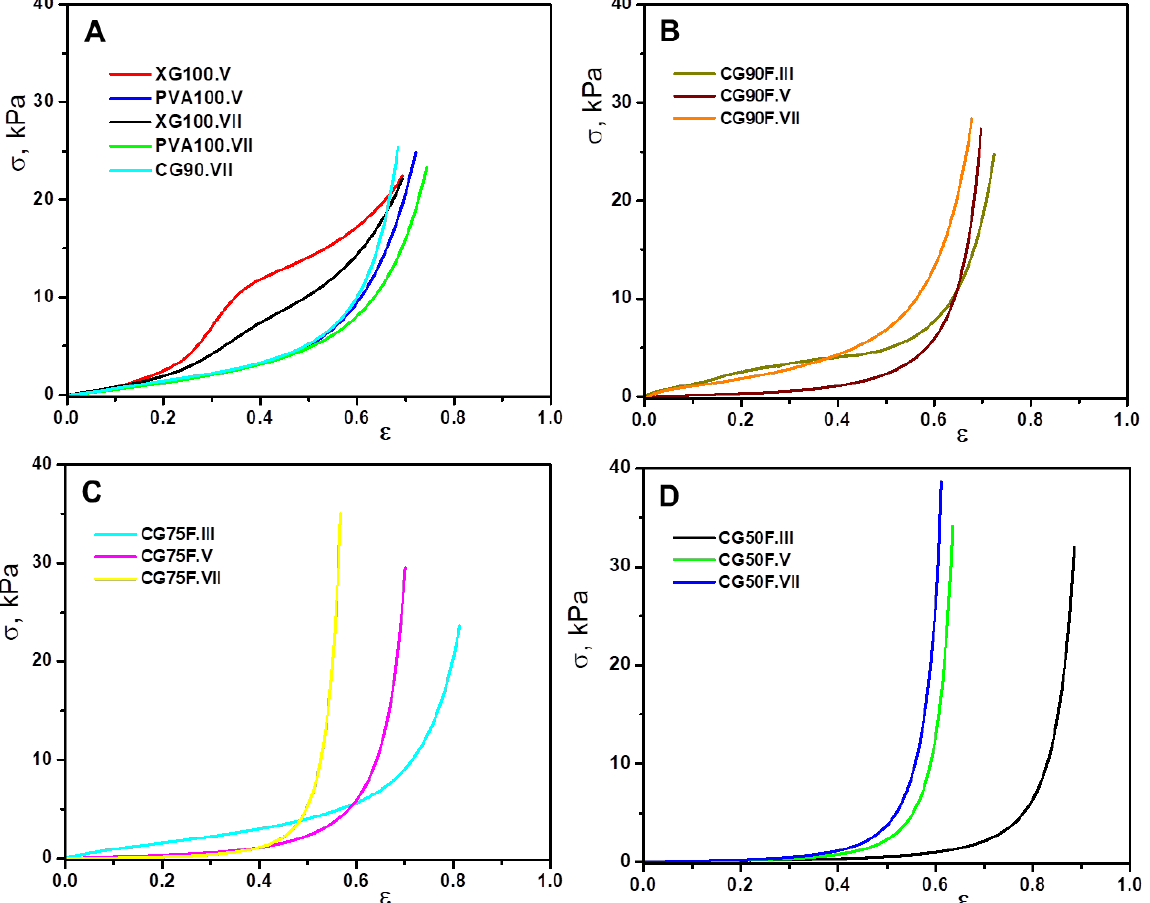
Figure 1. Stress - strain profiles of lyophilized XG - based composite hydrogels obtained by uniaxial compression using a cross - head speed of 0.2 mm min −1 and a force of 20 N: ( A ) control samples; ( B ) composite hydrogels prepared with a weight ratio between XG and PVA of 9:1; ( C ) composite hydrogels prepared with a weight ratio between XG and PVA of 3:1; ( D ) composite hydrogels prepared with a weight ratio between XG and PVA of 1:1.